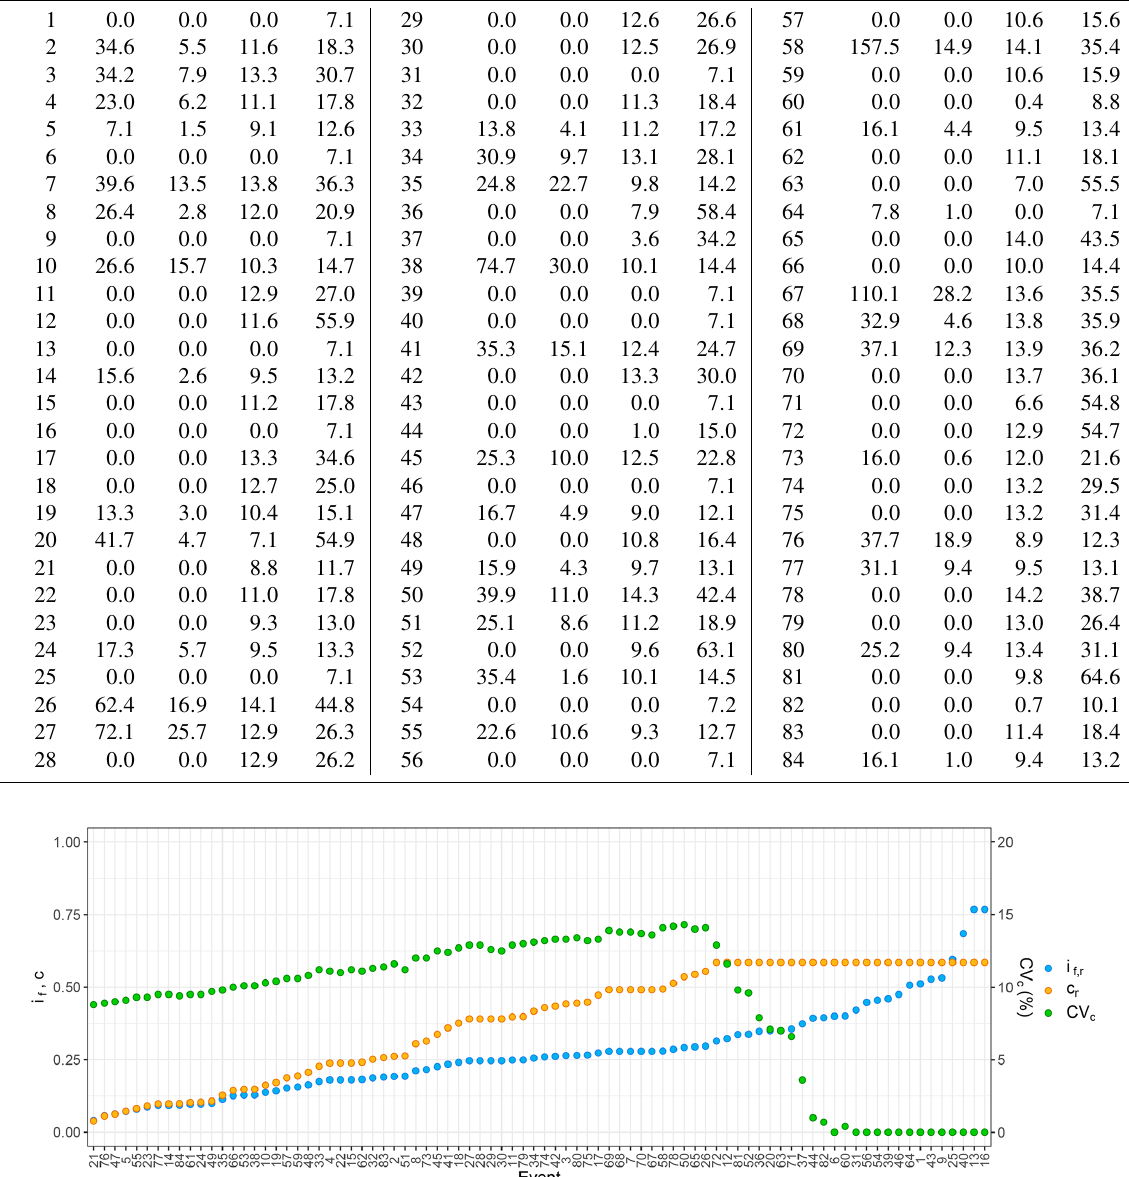
Figure 4. Reference slope i f , r and reference concentration c r and CV c of each event. The events have been sorted with increasing i f , r